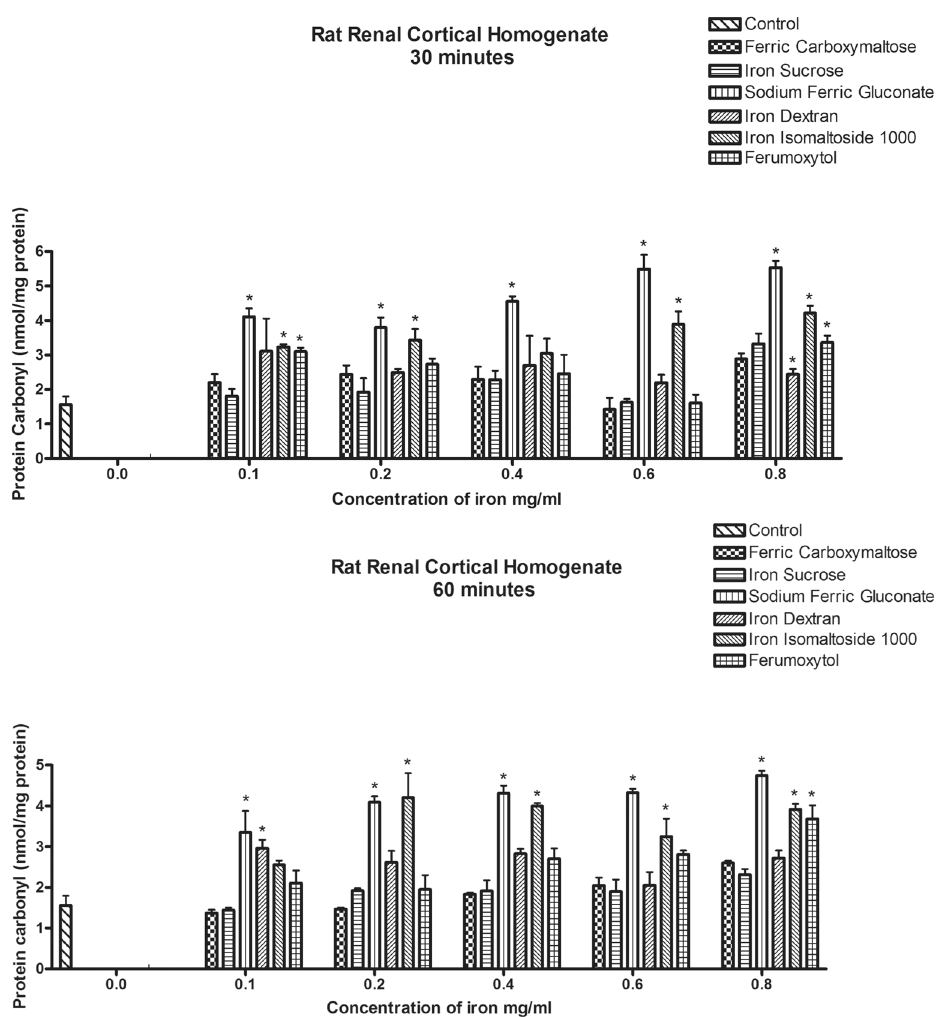
Fig 4. Effects of exposure of the iron compounds to Rat Renal Cortical Homogenates on expression of oxidatively modified proteins. The top figure (A) shows the results for 30 minutes of exposure and in the bottom figure (B), the results for 60 minutes of exposure. Data represents the mean ± SEM from three independent experiments and are compared to control for statistical significance using ANOVA and post-hoc testing. * p <